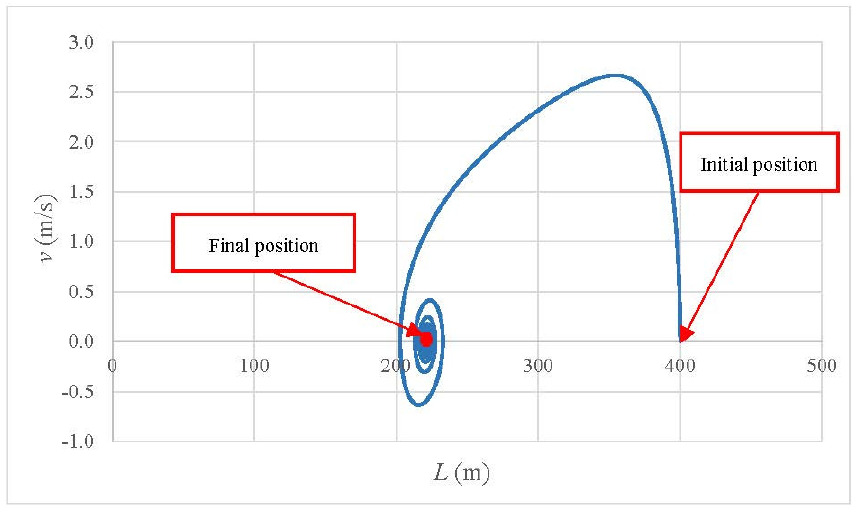
water velocity (2.66 m/s) is related to a water column length of 354.3 m. A spiral curve is presented towards the final position of the water column, reaching a water column length of 221.2 m. length of 221.2 m.